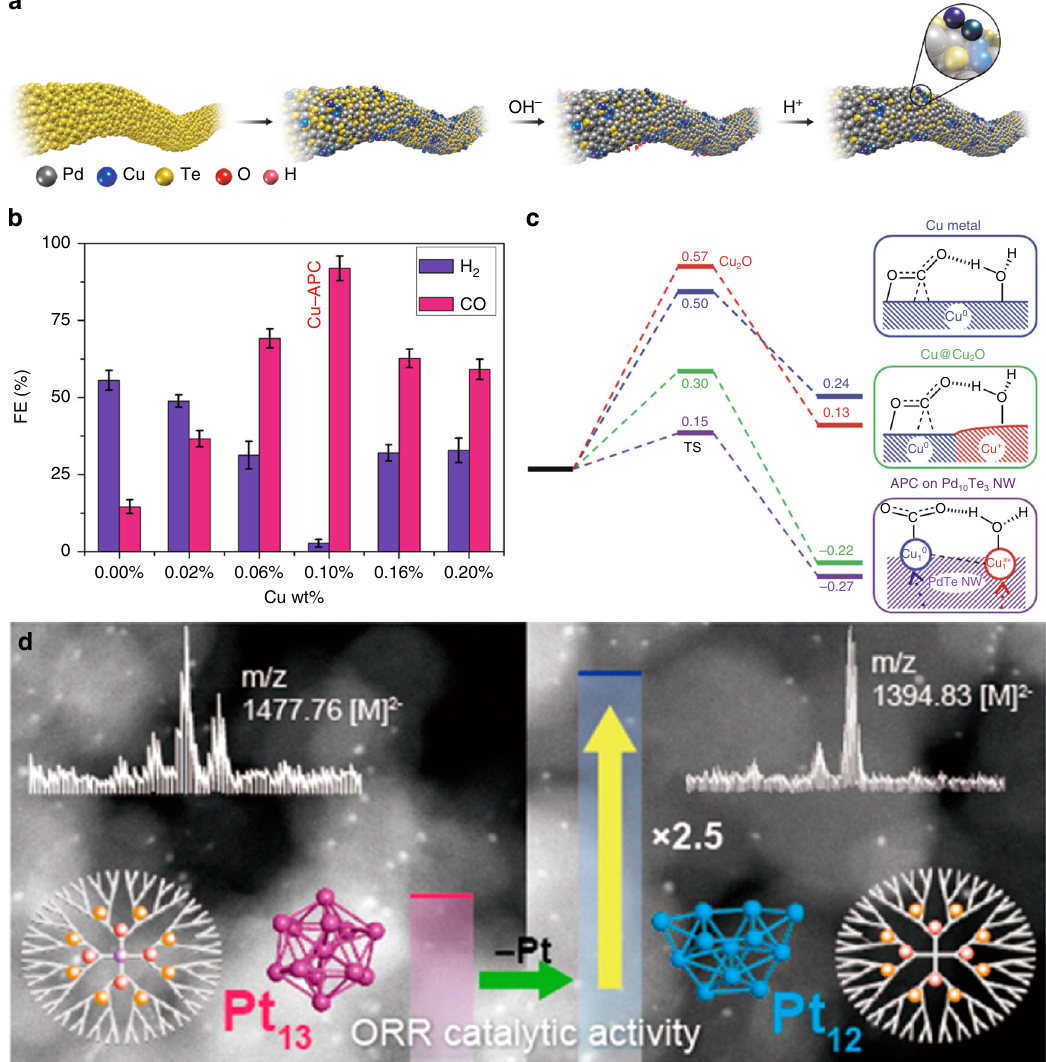
Fig. 6 The wet chemical reduction and dendrimer-based strategies. a Schematic illustration of the synthesis of atom-pair structured Cu anchored on Pd 10 Te 3 nanowires. b FE CO and FE H2 of samples with different Cu loading at − 0.78 V (versus RHE) in CO 2 RR. c Free energy pro fi les for CO 2 activation on Cu, Cu@Cu 2 O, and APC of Cu 1 0 – Cu 1 x + on Pd 10 Te 3 nanowires. Reprinted by permission from Springer Nature Limited: Springer Nature, Nature Chemistry , ref. 30 (Jiao et al). Copyright (2019). d HAADF-STEM images and ORR catalytic activity of Pt 13 (left) and Pt 12 (right) clusters supported on mesoporous carbon. Reprinted by permission from ref. 2 . Copyright (2013) American Chemical